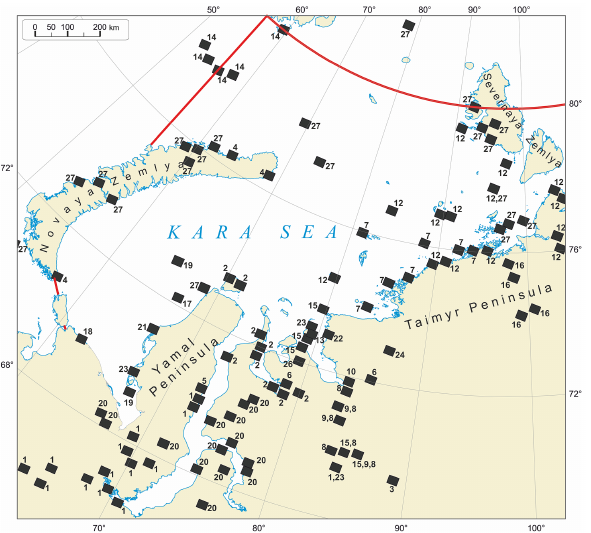
Figure 2. Late Pleistocene geology of the Kara region: data cover- age (the red line is the research region boundary). Black squares are sites studied in different years by different research teams. Numbers